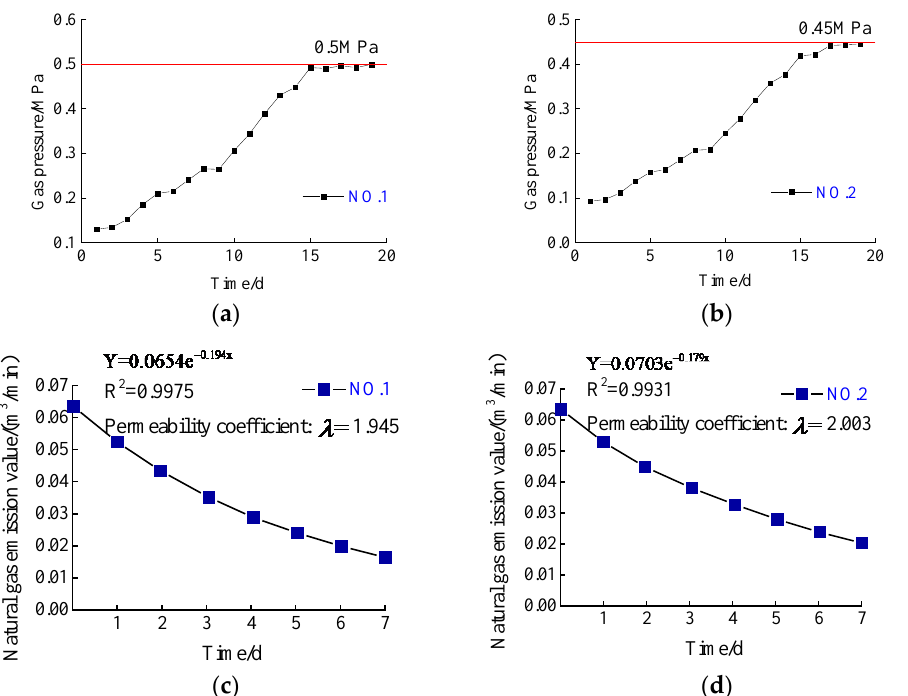
Figure 7. Ding protects Wu area: ( a ) NO. 1 measuring point gas pressure test data; ( b ) NO. 2 measuring gas pressure point test data; ( c ) NO. 1 measuring point permeability coefficient test data; ( d ) NO. 2 measuring point permeability coefficient test data.